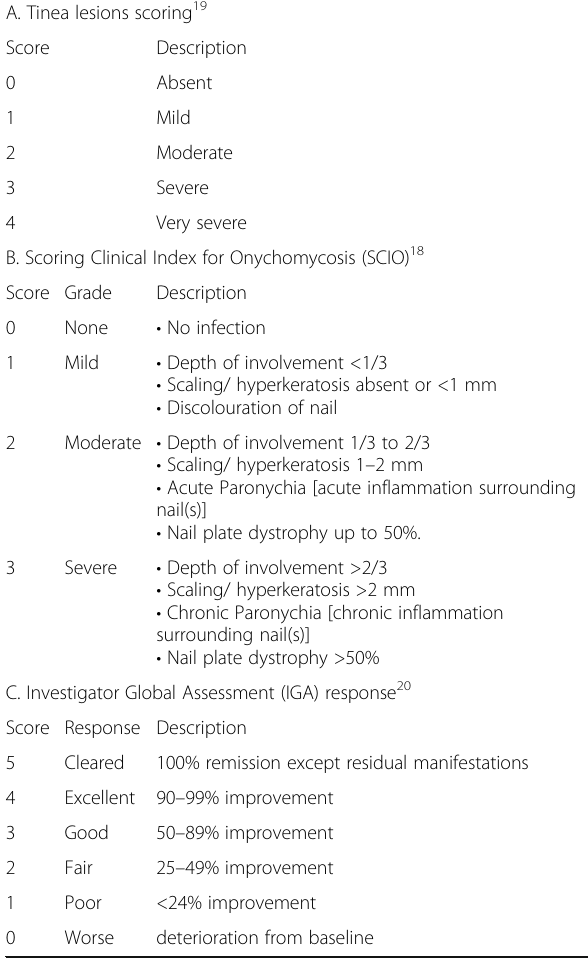
Table 1 Benchmark for secondary efficacy